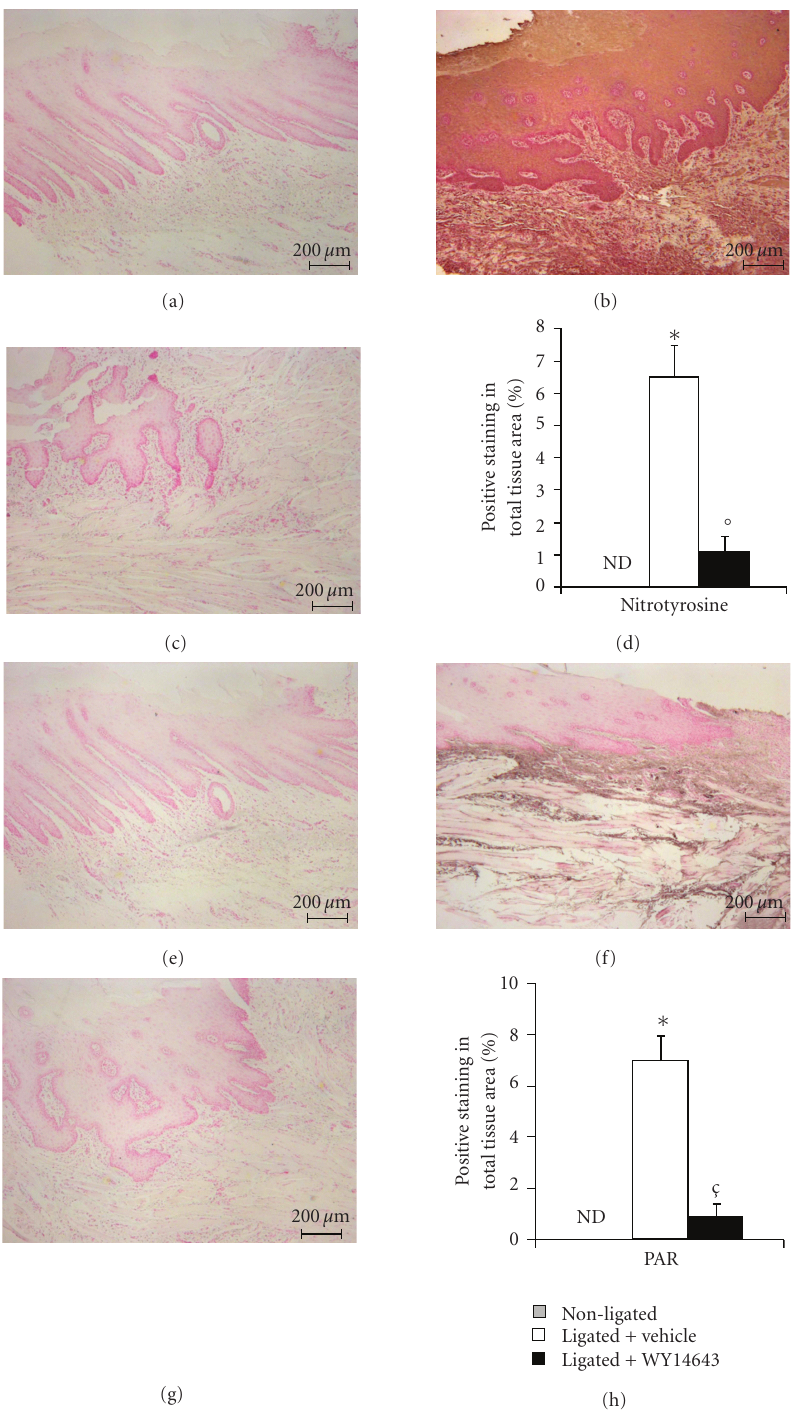
Figure 6: E ff ect of WY14643 on ligature-induced nitrotyrosine formation and PARP activation. No positive staining for nitrotyrosine was observed in gingivomucosal tissues from the contra lateral side obtained from vehicle-treated rats. (a) Positive staining for nitrotyrosine (b) was observed in gingivomucosal tissue after ligature. In gingivomucosal tissue of WY14643 treated rats no positive nitrotyrosine staining was observed. (c) In addition, immunohistochemistry for PAR, an indicator of in vivo PARP activation, revealed the occurrence of positive staining for PAR localized in gingivomucosal tissue after ligature. (f) WY14643 treatment reduced the degree of positive staining for PAR (g) in the gingivomucosal tissue. No positive staining for PAR was observed in gingivomucosal tissues from the contra lateral side obtained from vehicle-treated rats (e). Densitometry analysis of immunocytochemistry photographs ((d, h); n = 5 photos from each samples collected from all rats in each experimental group) for nitrotyrosine and PAR from gingivomucosal tissue was assessed. The assay was carried out by using Optilab Graftek software on a Macintosh personal computer (CPU G3-266). Densitometry data are expressed as % of total tissue area. Figure is representative of at least 3 experiments performed on di ff erent experimental days. ∗ P < . 01 versus nonligated. ◦ P < . 01 versus